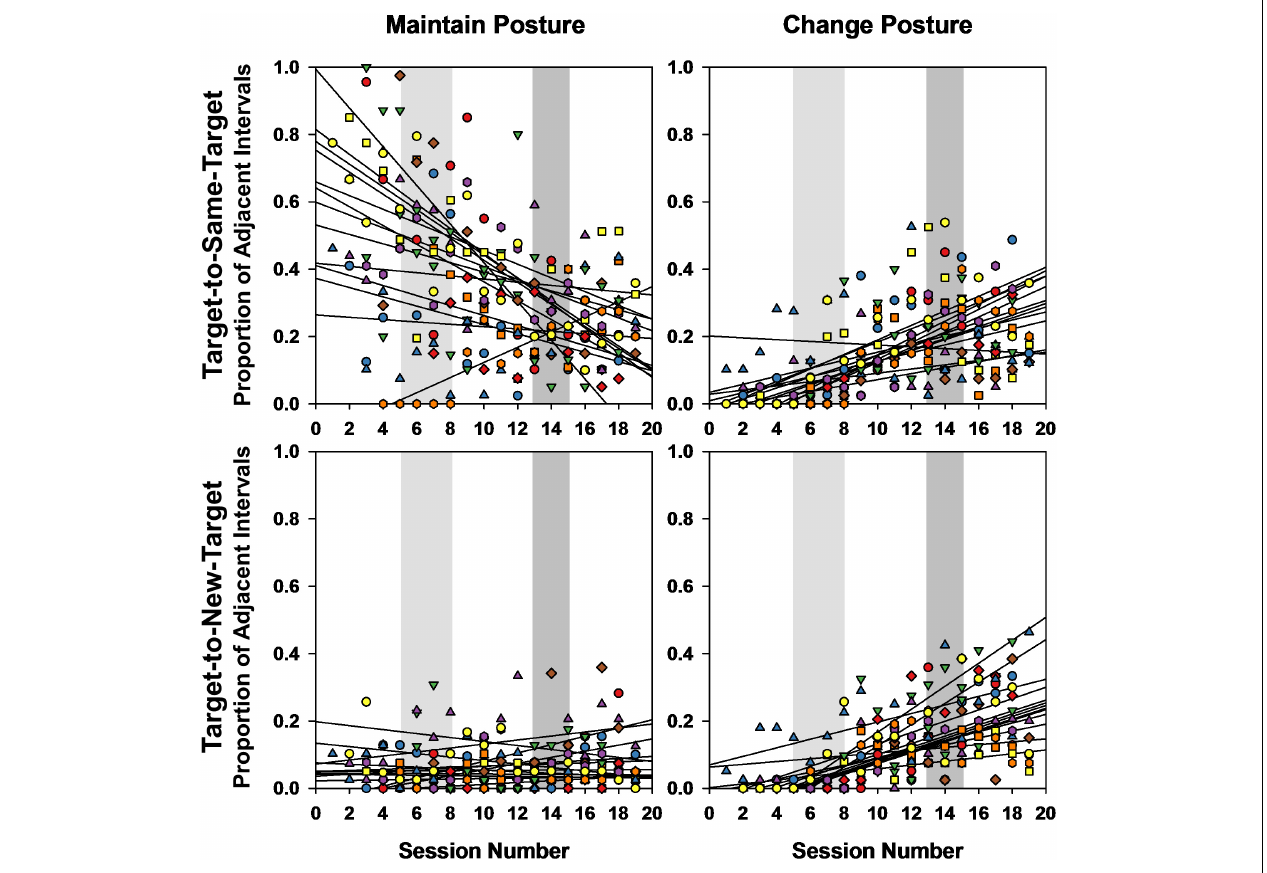
FIGURE 9 | Pearson correlations and corresponding regression lines showing the relation between the proportion of transitions infants engaged in transitions from target-to-same-target (top) and target-to-new-target (bottom), while also maintaining (left) or changing posture (right), by session number. Light gray and darker gray shaded areas span the range of session numbers during which different infants learned to crawl and walk,